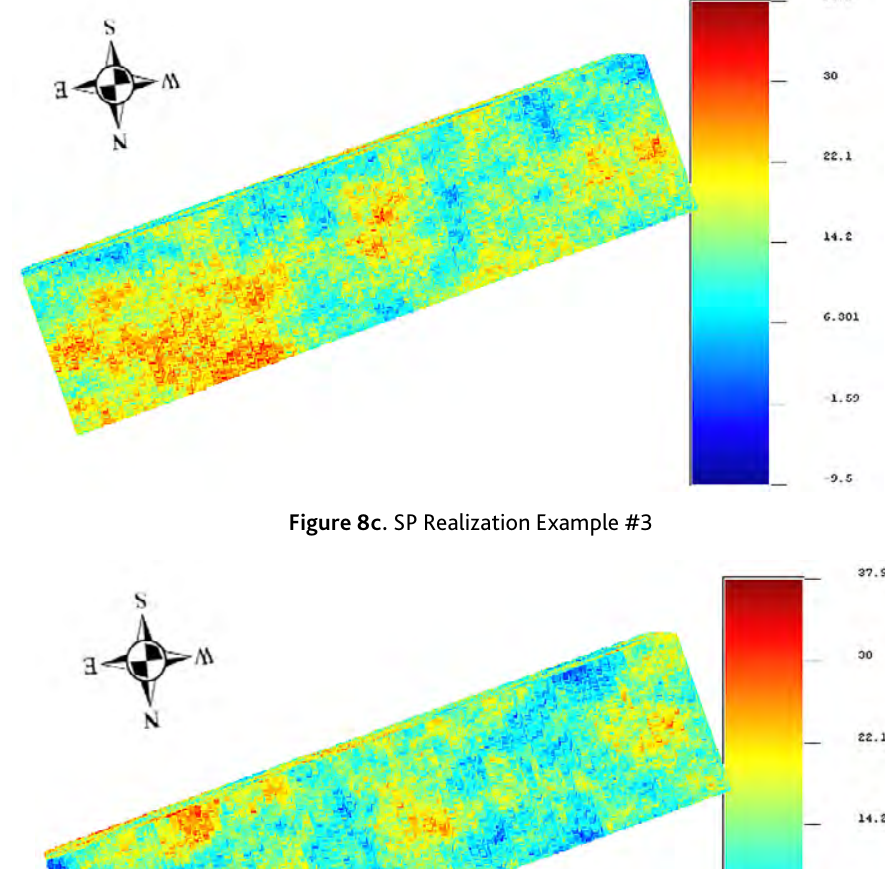
Figure 8c. SP Realization Example #3